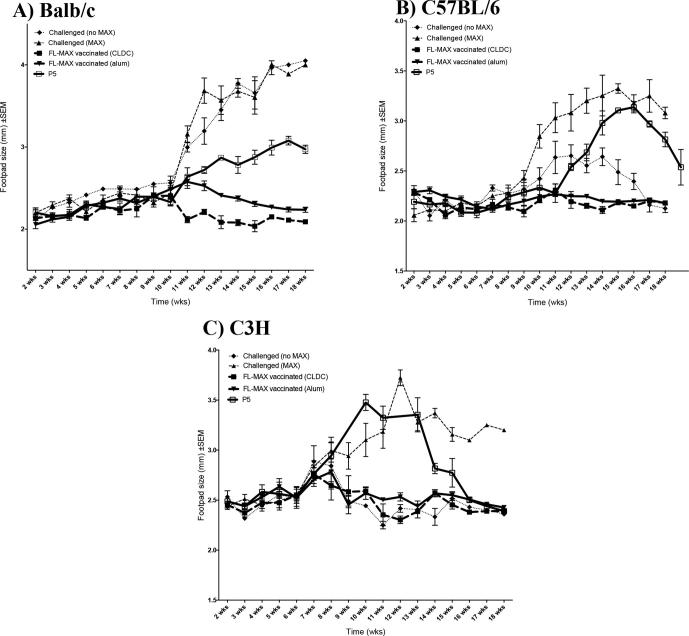
Vaccination of mice with P5-CLDC failed to improve lesion induration over the 18 week course after MAX + Lm challenge and immunization of BALB/c mice with FL-MAX (CLDC) yielded significantly better lesion healing verses the FL-MAX(alum) formulation as assessed by lesion size. Footpad size was determined for (A) Balb/c, (B) C57BL/6 and (C) C3H mice that were either challenged with 100-1000 Lm metacyclic promastigotes alone (dotted lines, solid diamonds), challenged similarly with Lm admixed with 10 ng MAX (dashed lines, solid triangles), or challenged with Lm + MAX after being vaccinated/boosted with CLDC prepared with the non-efficacious P5 peptide(solid thick line, open squares), FL-MAX-alum (solid thick lines, inverted solid triangles) and FL-MAX-CLDC (thick solid dashed line, solid squares). All mice were challenged one week after the boost. Lesions were measured over an 18 week period using Vernier® calipers. Two independent investigators who were blinded from the treatment types performed the measurements.